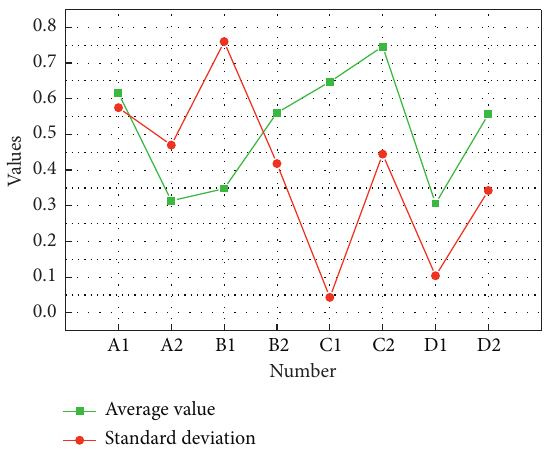
Figure 9: Descriptive statistics of sports virtual simulation